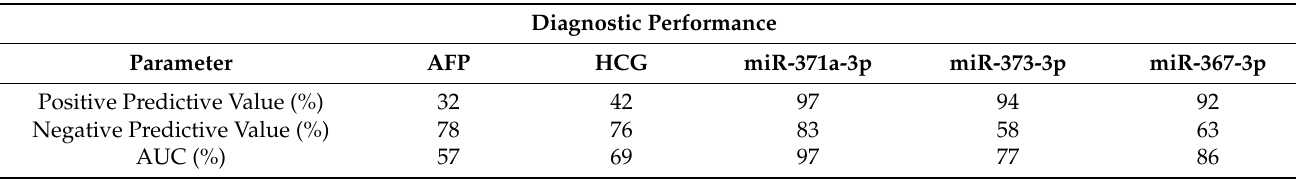
Abbreviations: AUC—area under the